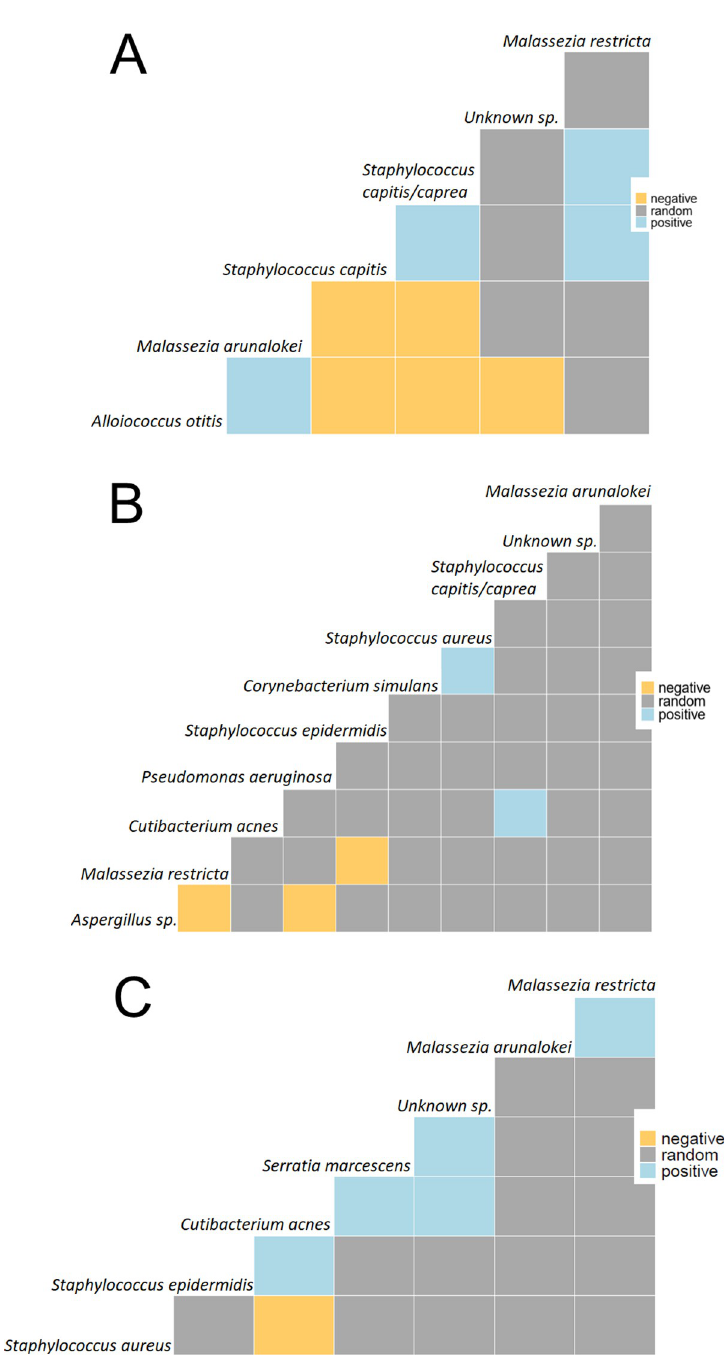
Fig 5. Co-occurrence analysis. Microbial interactions between bacterial and fungal species in each study group. Negative interactions between species are shown in yellow, positive interactions are shown in blue and no significant interaction is shown in grey. (A) healthy, (B) otitis externa, and (C) otitis